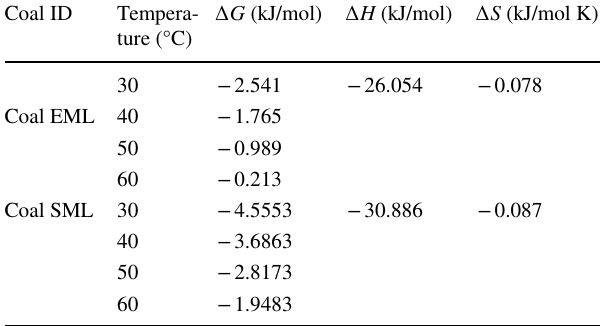
Table 2 Thermodynamic parameters for CO EML and Coal